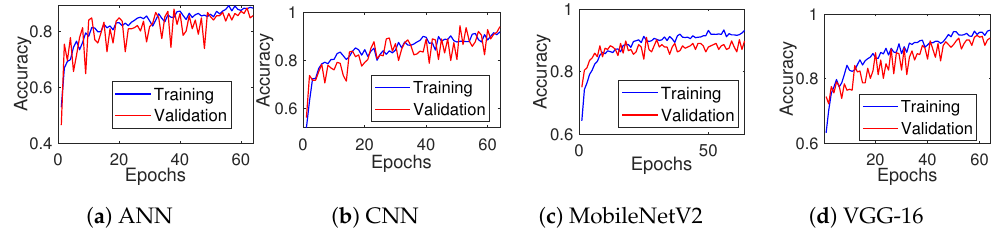
Figure 5. Models accuracy on Pest pattern classification. Table 8. Pest pattern